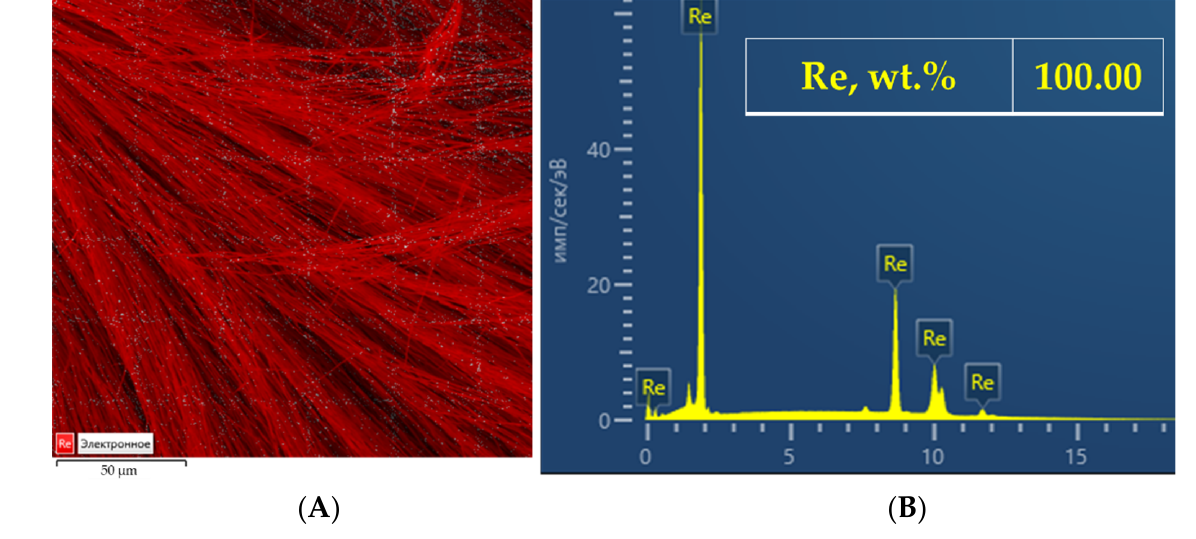
Figure 9. XRD diffraction pattern of the rhenium deposit obtained during the electrolysis in the KF-KBF 4 -B 2 O 3 -KReO 4 melt.